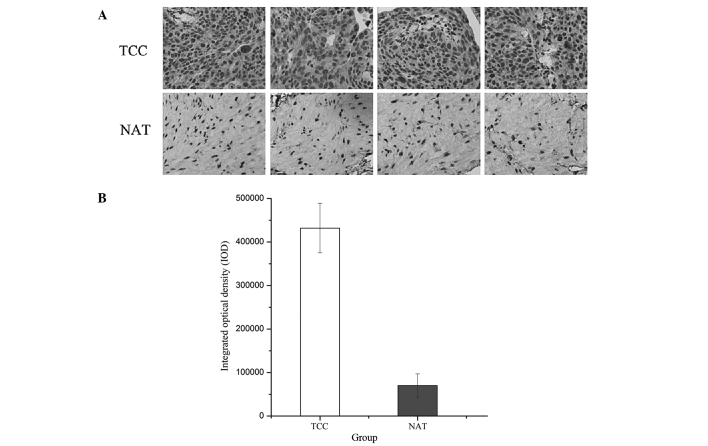
(A) Representative immunohistochemical staining for B7-H3 in TCCs and NATs. B7-H3 protein levels were significantly upregulated in the TCC samples compared with the paired NAT samples. (B) Integrated optical density represents the immunostaining intensity of B7-H3 in TCC and NAT samples. The mean B7-H3 protein level was significantly higher in the TCC samples compared with the paired NAT samples (P<0.05; staining, hematoxylin and eosin). Error bars present the standard error of the mean. TCC, transitional cell carcinomas; NAT, normal adjacent tissue.